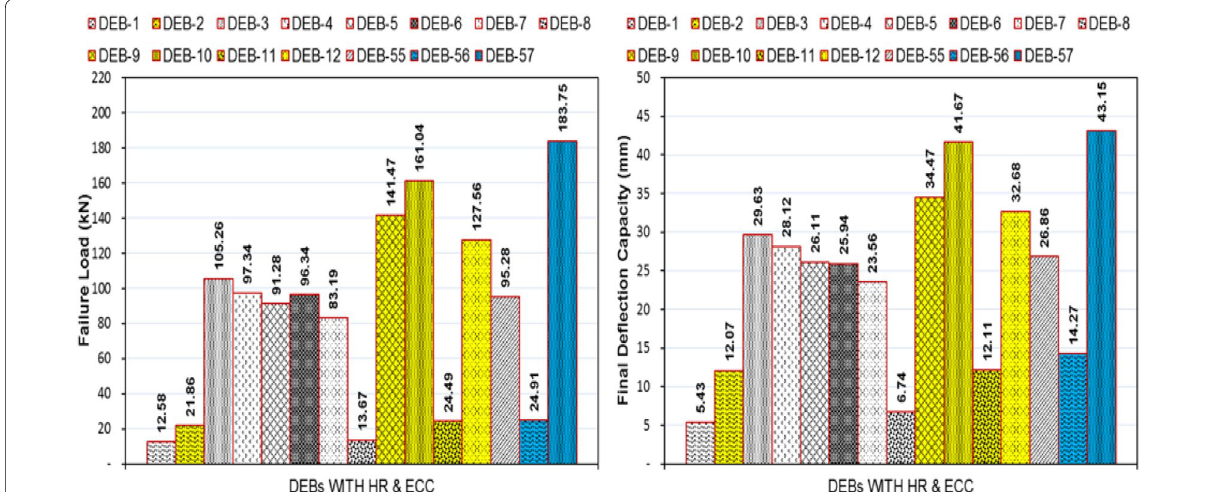
Fig. 7 Failure load and final deflection capacity in the first